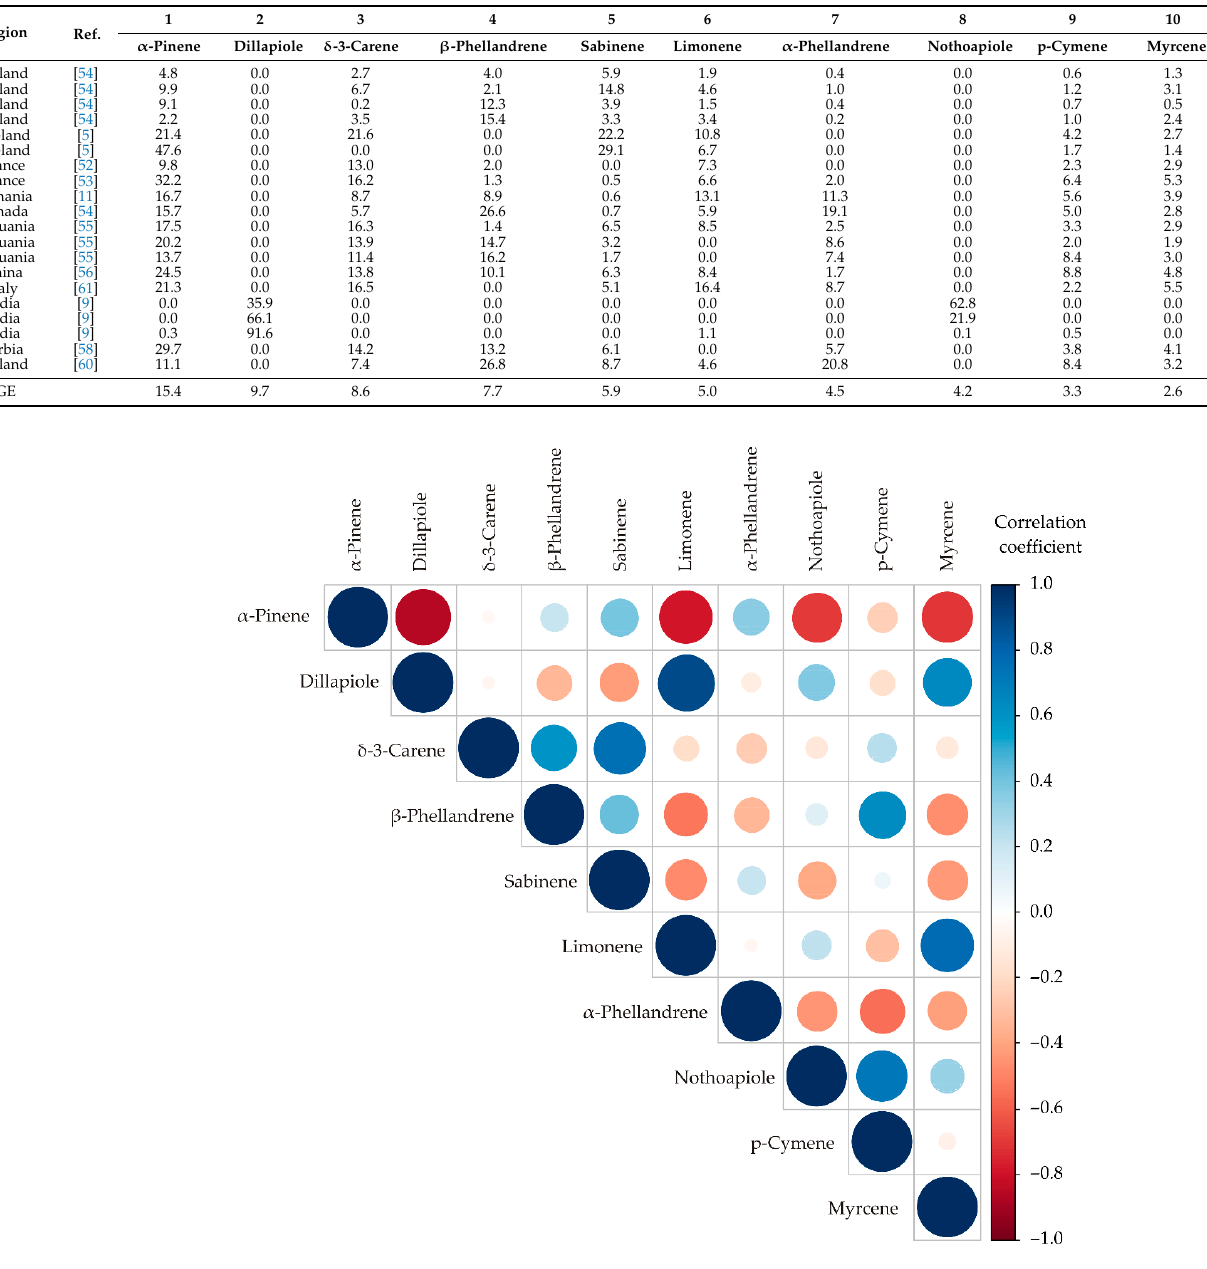
Figure 1. Correlations between different A. archangelica root volatile compounds.